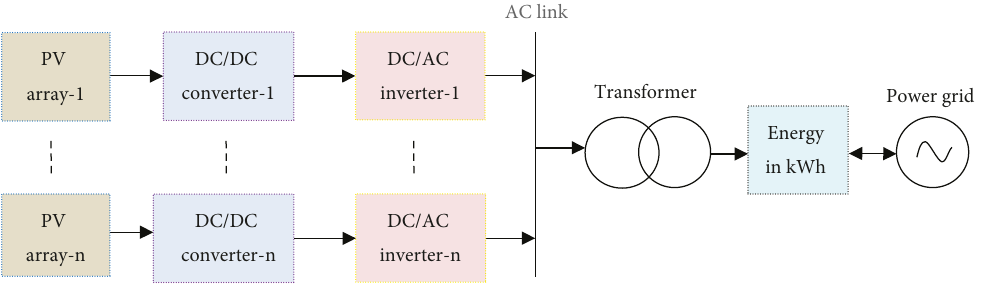
Figure 2: Grid-connected PV power